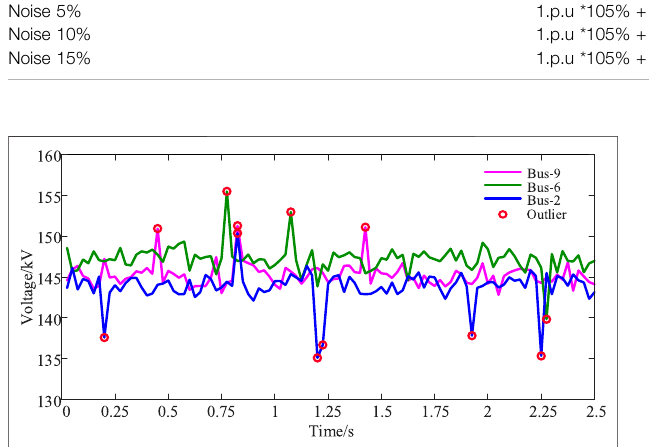
FIGURE 6 | The segment of synthetic noise-5% PMU data.